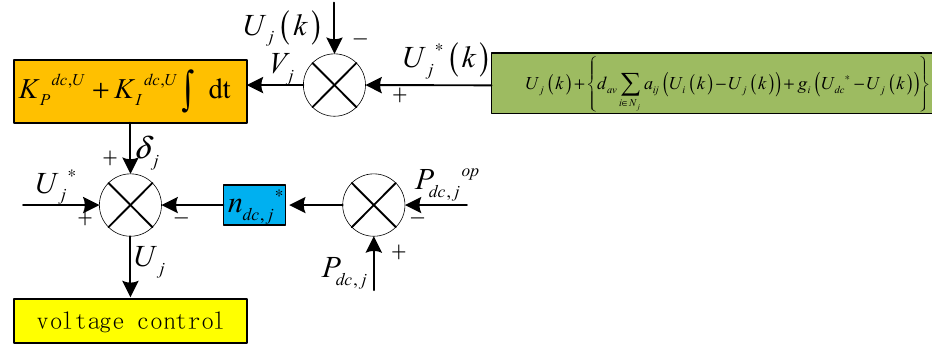
Figure 4. DC subnet control block diagram.